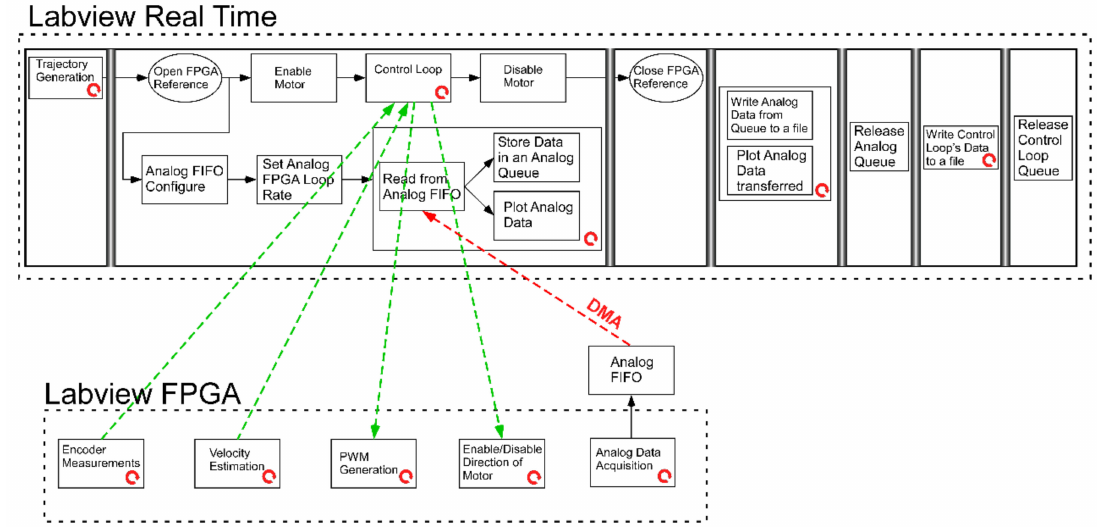
Figure A4. Flow chart of the integrated control and acquisition system, where DMA and FIFO denote direct memory access and first in, first out sequence,